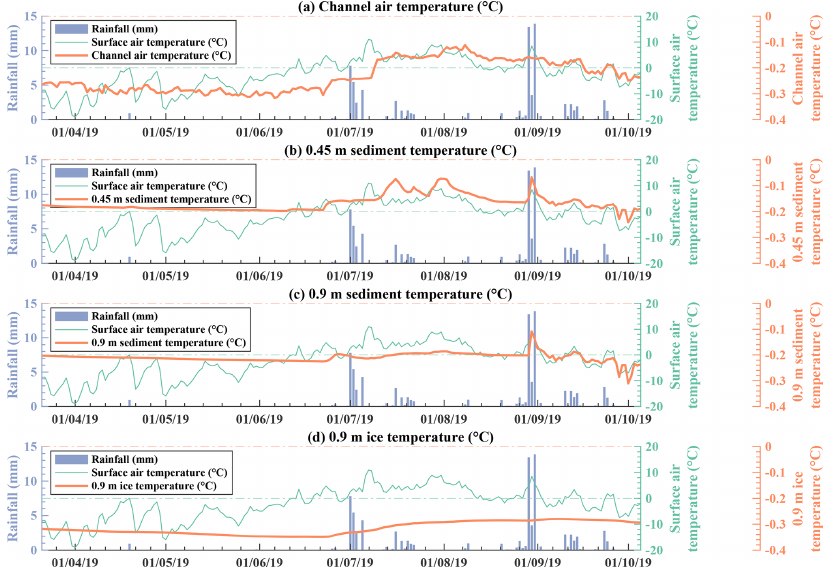
Figure 9. Subglacial temperatures at location Subglacial 2. (a) Time series of daily mean channel air temperature, modeled surface air temperature and modeled rainfall. (b) Time series of daily mean 0.45m depth sediment temperature, modeled surface air temperature and modeled rainfall. (c) Time series of daily mean 0.9m depth sediment temperature, modeled surface air temperature and modeled rainfall. (d) Time series of daily mean 0.9m depth ice temperature, modeled surface air temperature and modeled